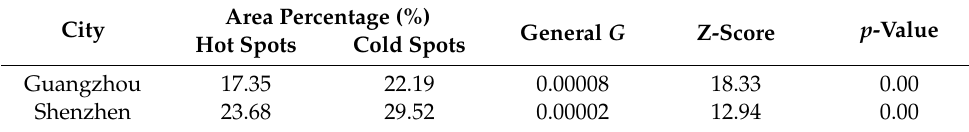
Table 5. Descriptive statistics of urban waterlogging hot spots and cold spots.